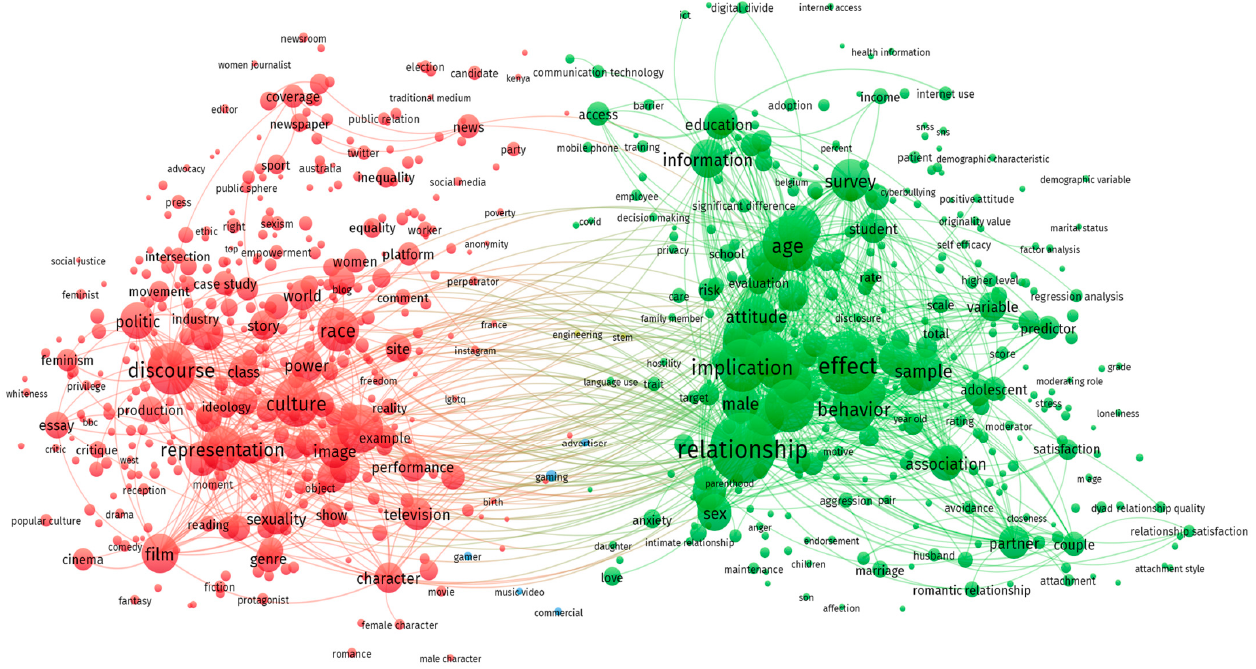
Figure 3. Network visualization of term co-occurrence map based on text data with weights based on occurrences.